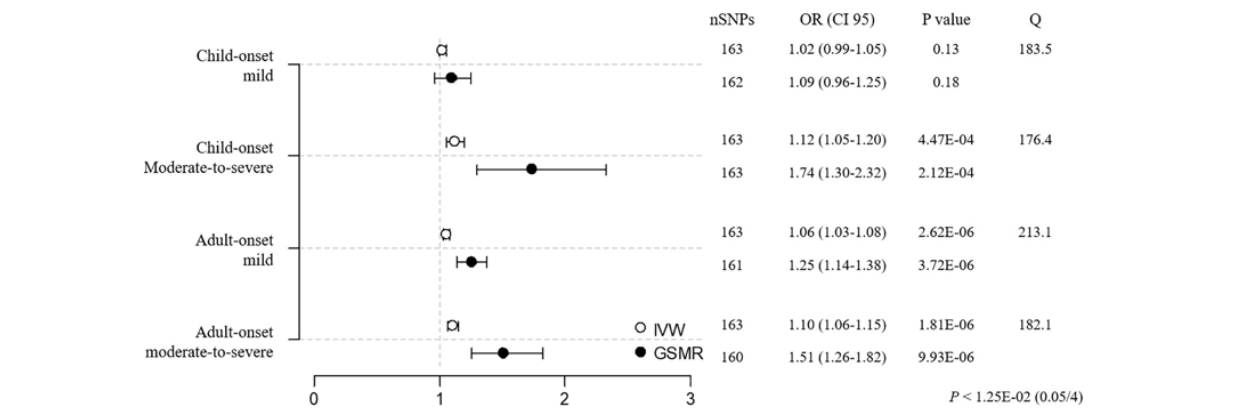
FIGURE 3 | MR estimates of associations between BMI and asthma subtypes. The odds ratio is plotted as dots with the 95% confidence interval. White dots are the IVW method and black dots are the GSMR method. The P value indicates significance when P < 1.25E-02 (0.05/4) by a Bonferroni correction. The Q value by Cochran’s Q statistic indicates residual heterogeneity in the MR